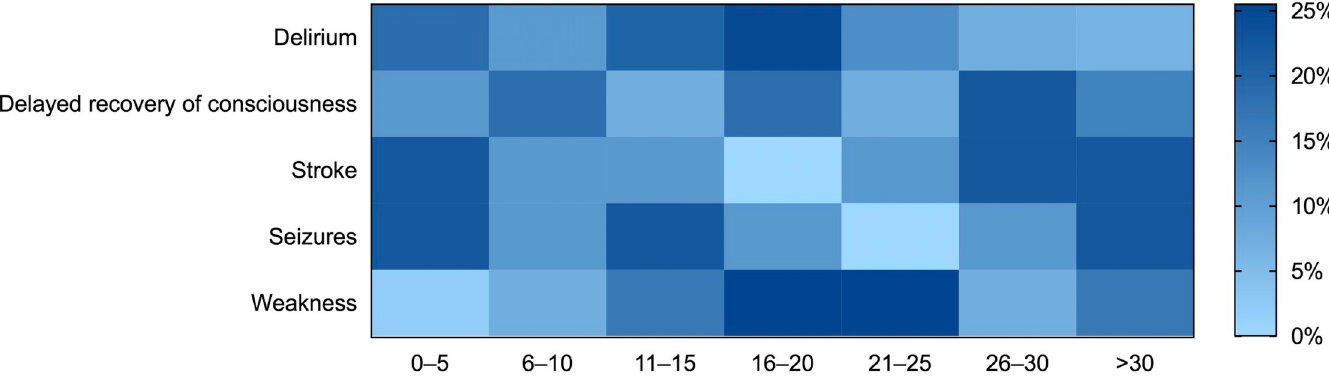
Fig 1. Days from admission to the appearance of neurologic events. Delayed recovery of consciousness was defined as a persistent altered mental status lasting longer than four half-lives after the withdrawal of sedative drugs.